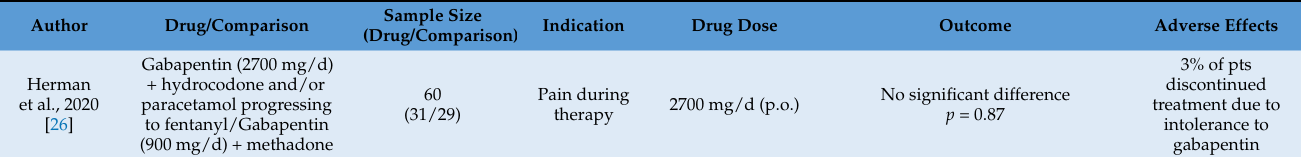
Table 3. Efficacy and safety of the used